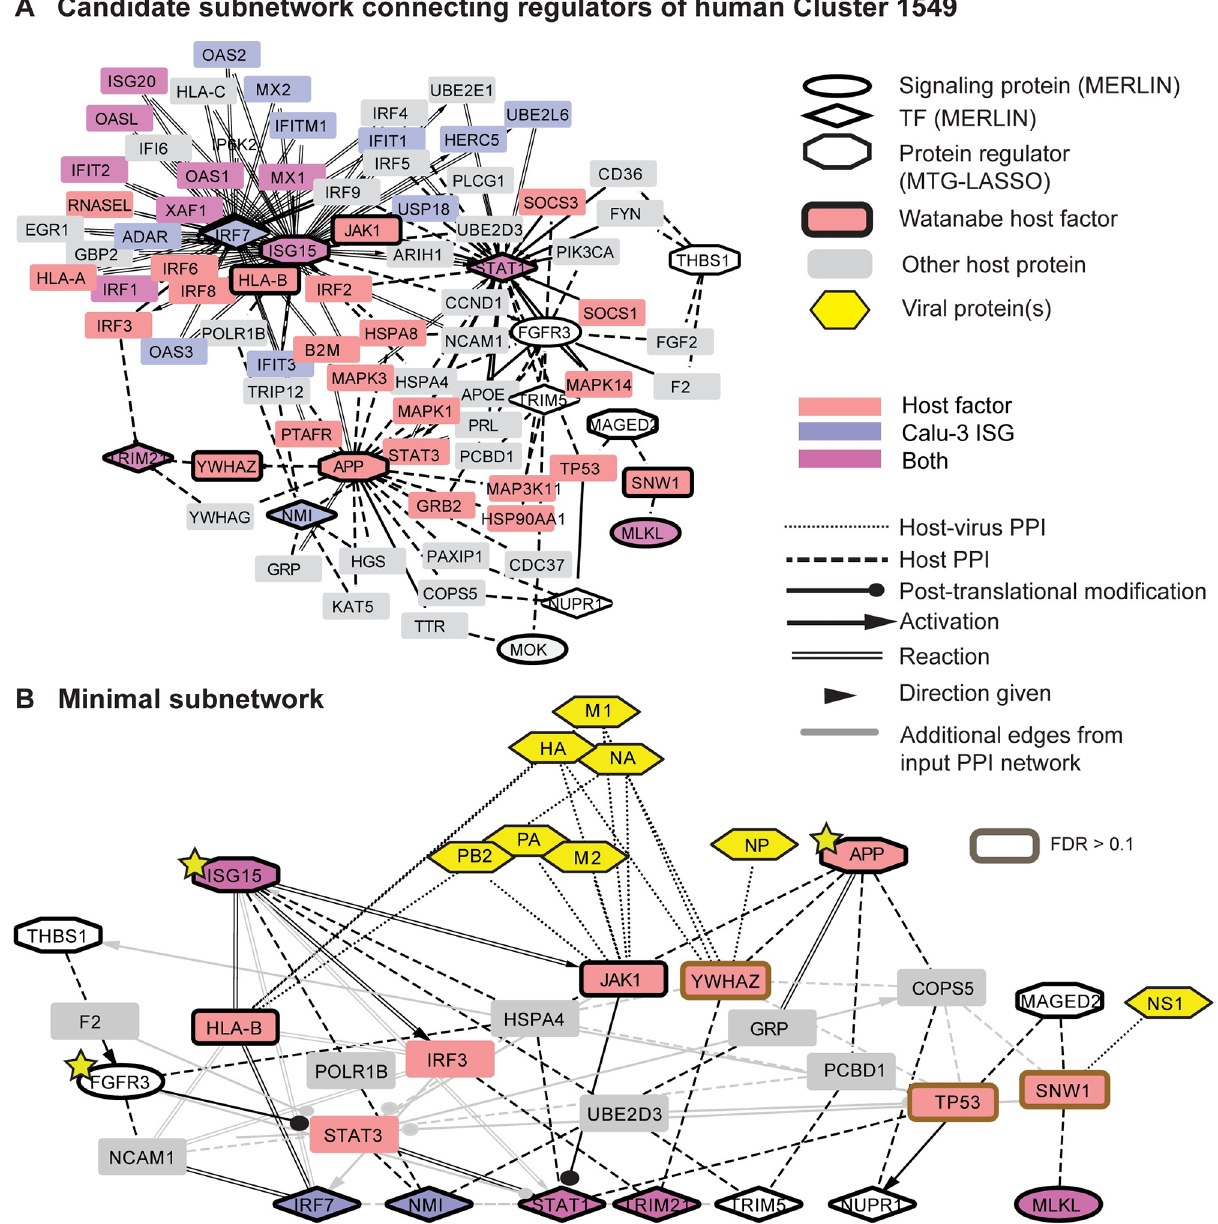
Fig 7. Integration of expression- and protein-based regulators into a physical subnetwork for module 1549. A. Candidate subnetwork for module 1549 given as input to the Integer Linear Programming (ILP) approach to find a minimal network. The candidate subnetwork is extracted from the background interaction network by connecting MERLIN (mRNA) and MTG-LASSO (protein) regulators through at most one intermediate node and mRNA signaling proteins to TFs ( Materials and Methods ). Nodes with dark outlines are input to the ILP-based subnetwork inference method: MERLIN regulators (diamonds and ellipses), protein regulators (octagons), and host genes for influenza identified by Watanabe et al (2014) (boxes). Nodes without borders are candidate intermediates between two regulators and were not given special treatment by the method. Node color indicates host genes involved in influenza obtained from siRNA or protein interaction studies and Calu-3 ISGs (as in Fig 3 ); this information is for visualization purposes and is not used in the subnetwork inference method. Only edges between intermediate nodes and input nodes are shown. Additional available protein-protein interactions between intermediate nodes are not shown for visual clarity. B. Minimal subnetwork for Cluster 1549's regulators inferred using ILP. Yellow stars indicate host genes for which siRNA knockdown significantly impacted viral replication. Also shown are interactions between Watanabe host genes and viral proteins (yellow hexagons). Grey edges are input to the method but not selected by the approach. All selected edges and all nodes other than YWHAZ, TP53, SNW1 (brown boxes) had FDR (cid:3) 0.10. FDR was assessed based on permutation tests.